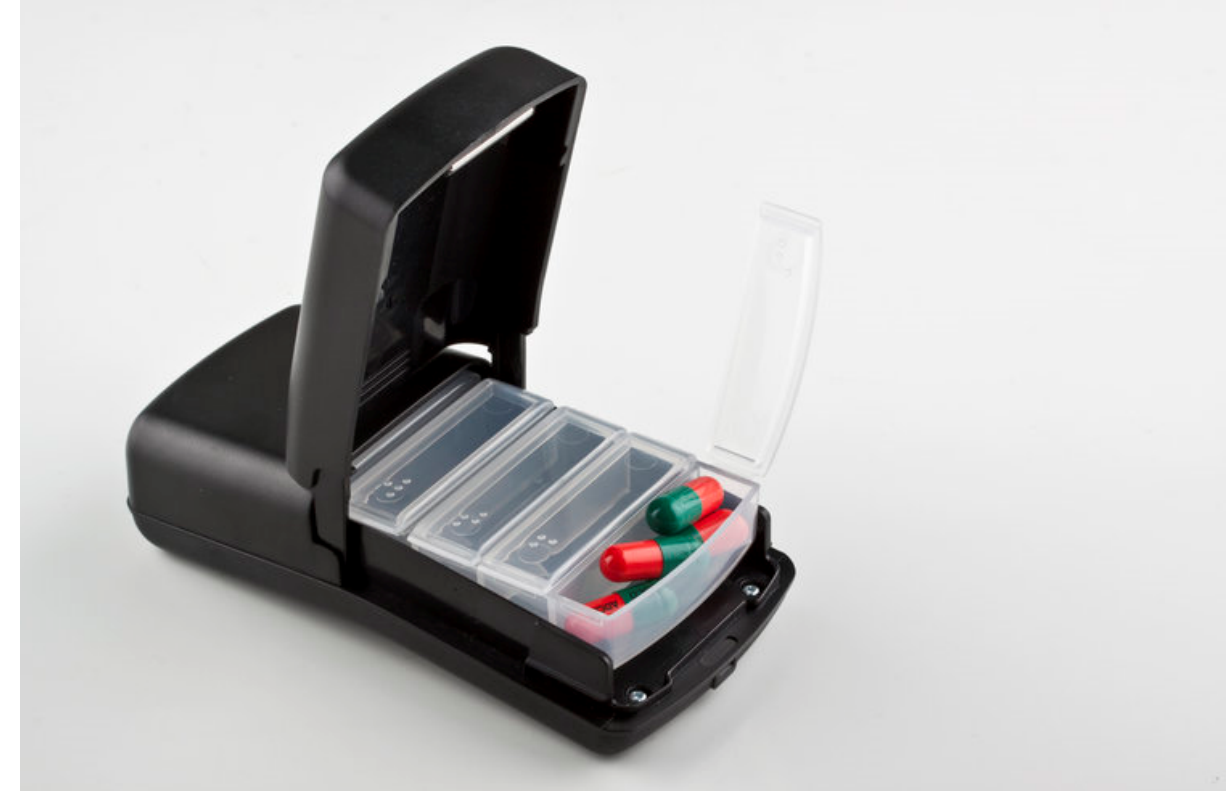
Figure 1. The Wisepill